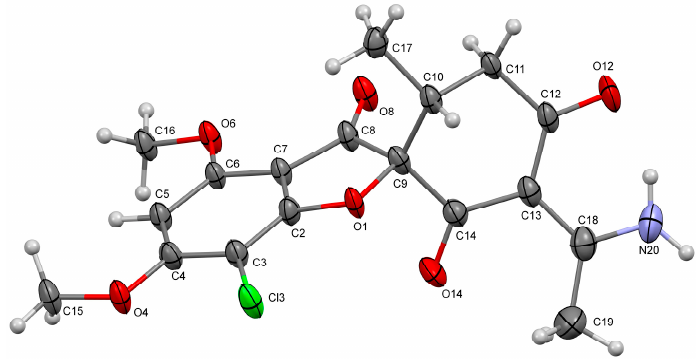
Figure 2. The X-ray crystal structure of compound 3 (CCDC 2240675).